Question: What style of plot is this figure drawn as?
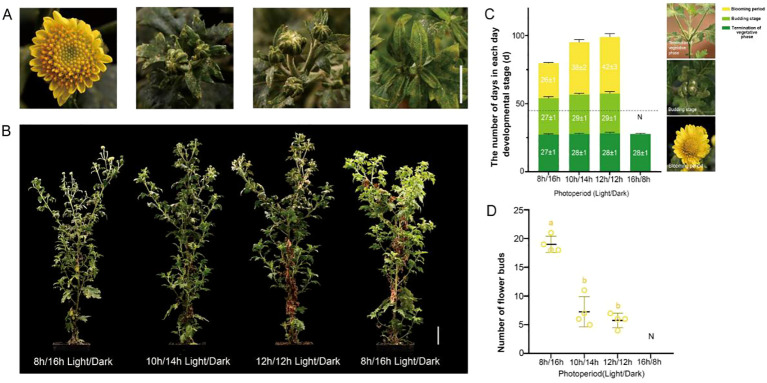
Answer: line